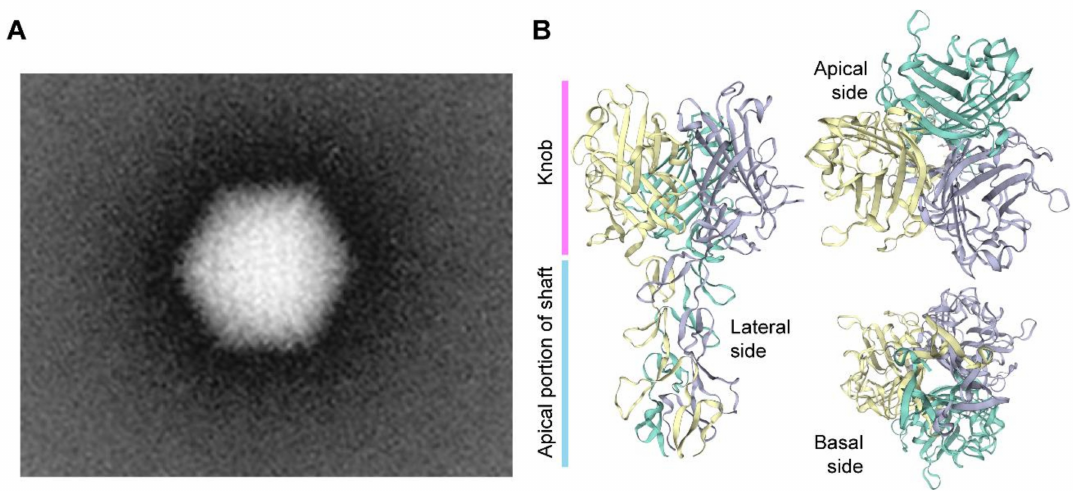
Figure 2. Adenovirus particle and the structure of its cell receptor-interacting fibers. ( A ) Transmission electronmicroscopyimageofanadenovirusparticle(virion).Theicosahedralshapeofthenon-enveloped virion capsid can be discerned (~90 nm). A few of the twelve slender protruding fibers with their apical globular knob domains responsible for the initial interaction with the host-cell coxsackie and adenovirus receptor (CAR), can equally be discerned. ( B ) Three-dimensional model of the apical regions of the adenovirus serotype 5 fiber. The fiber is a homotrimer of the polypeptide encoded by the L5 open reading frame and consists of the tail (not shown), the rod-like shaft and the globular knob domains. The tail anchors the fiber to the adenovirus capsid via non-covalent binding to the penton base proteins; the shaft projects the knob away from the capsid facilitating its interaction with CAR on the surface of host cells. The quaternary protein structure was homology-modeled using the SWISS-MODEL server and is depicted in di ff erent